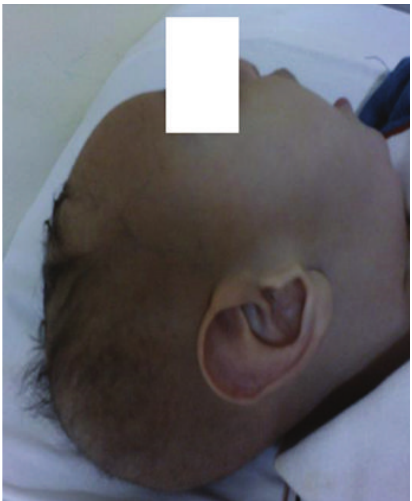
Figure 1: Characteristic phenotypical appearance of baby—fuzzy sparse thin scalp hairs, fair complexion.